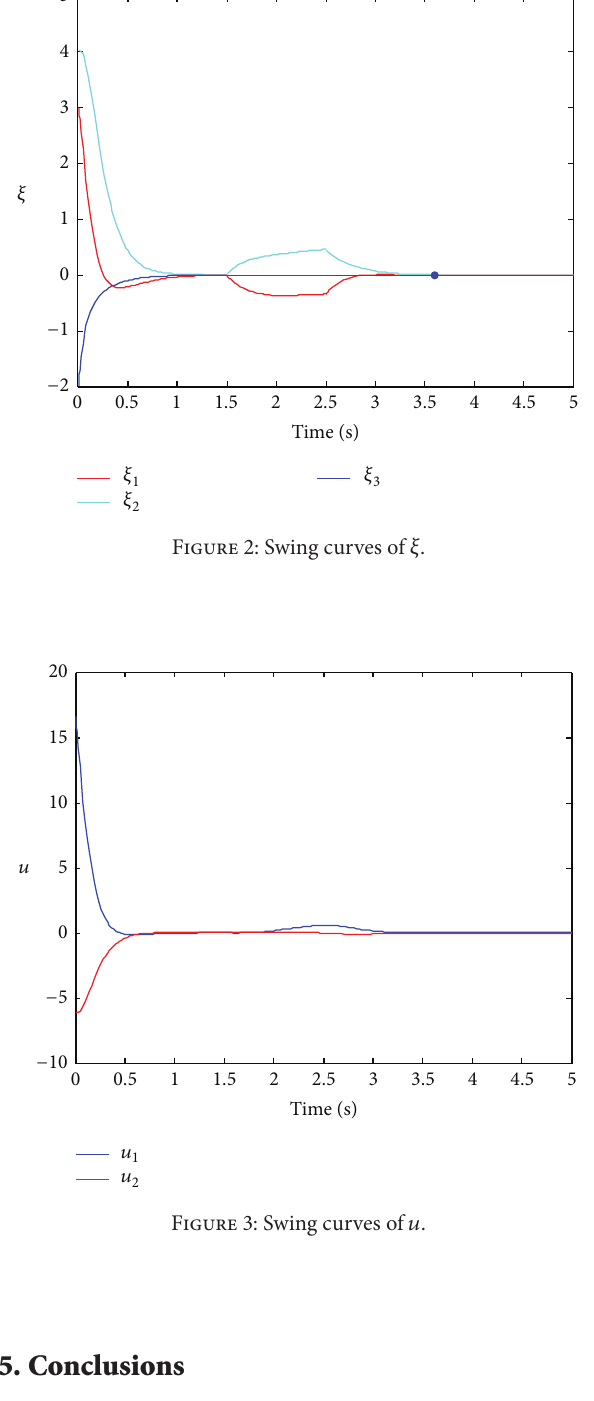
Figure 3: Swing curves of 𝑢